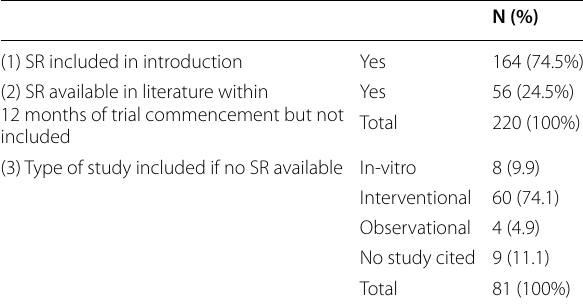
Table 1 The inclusion of a systematic review: (1) included in introduction, (2) available in literature within 12 months of trial commencement but not included and (3) Type of studies included when no systematic review was included in